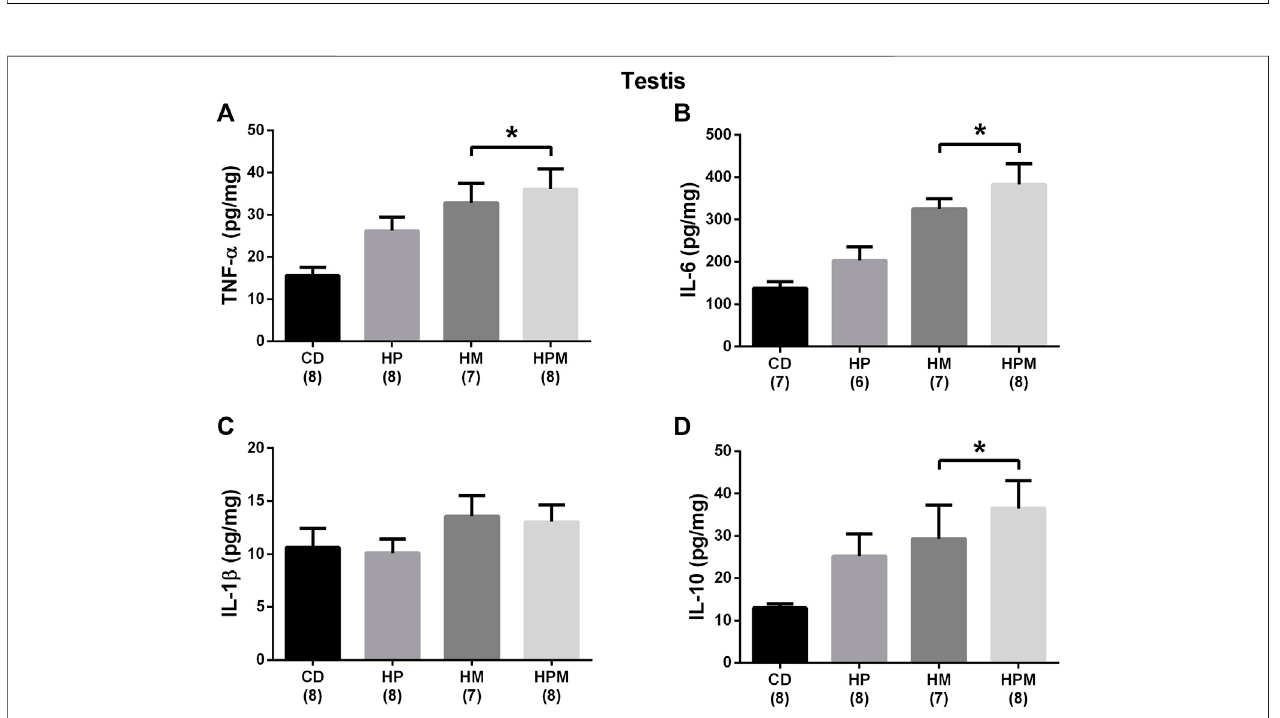
FIGURE 4 | Testicular cytokine levels in male rat offspring from progenitors fed on high-fat high-sugar diet. Mean ± SEM; symbols indicate signi fi cant difference caused by parental diet ( p < 0.05): *statistically signi fi cant by the effect of maternal diet. H: high-fat and high-sugar diet; CD (control paternal and maternal diet), HP (H paternal diet and control maternal diet), HM (H maternal diet and control paternal diet) and HPM (H paternal and maternal diet). (A) : tumor necrosis factor α (TNF- α ) (pg/ mg) ( n = 7-8); (B) : interleukin 6 (IL-6) (pg/mg) ( n = 6-8); (C) : interleukin 1 β (IL-1 β ) (pg/mg) ( n = 7-8); (D) : interleukin 10 (IL-10) (pg/mg) ( n = 7-8).